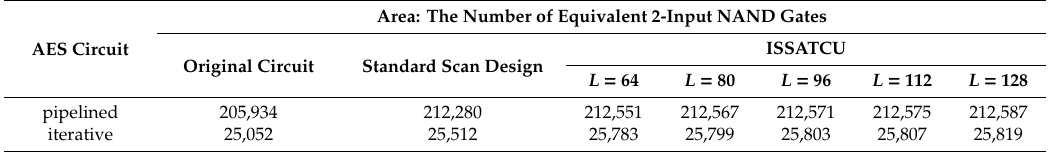
Table 1. Areas of original circuit, standard scan design and proposed ISSATCU.